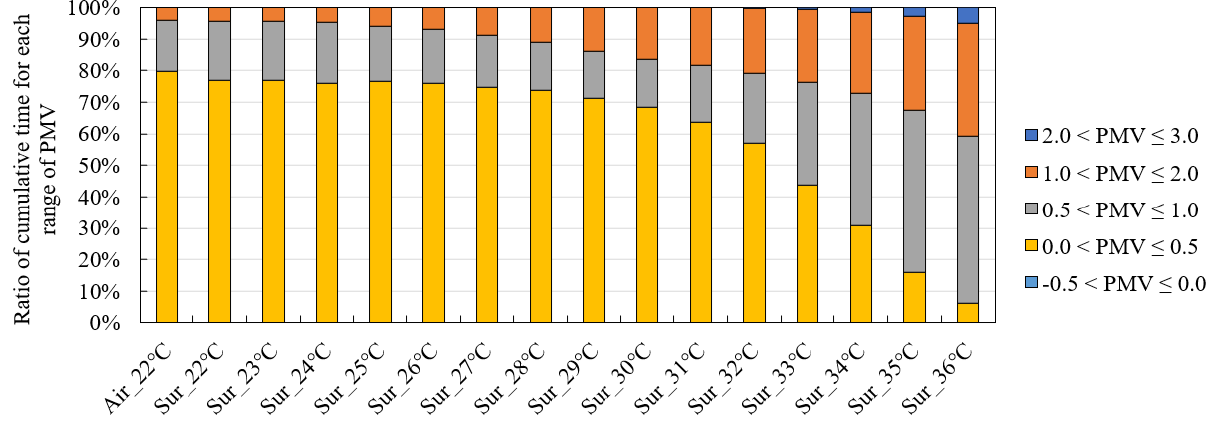
Figure 19. Ratio of cumulative time for each range of PMV for the room zone.